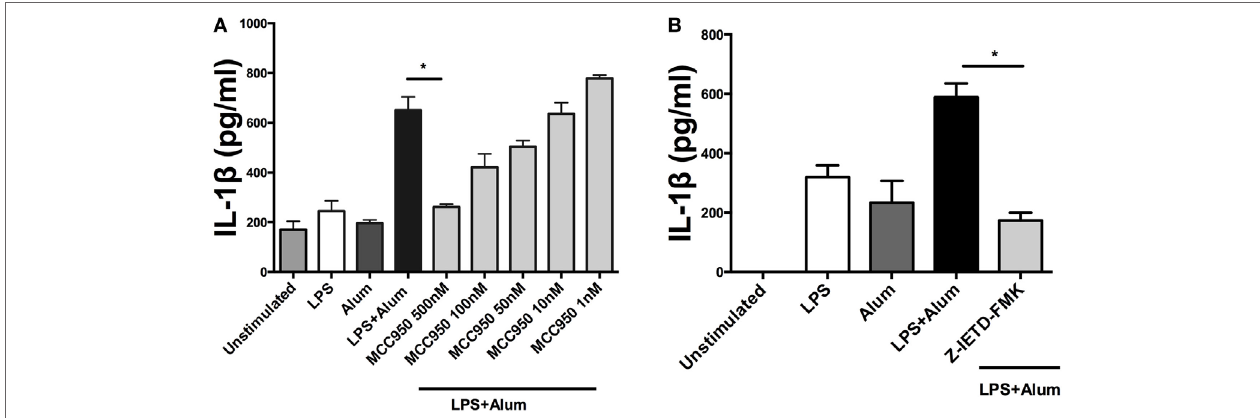
FigUre 5 | Alum-induced IL-1 β secretion is NLRP3 and caspase-8 dependent. LPS (100 pg/ml)-primed cells from three animals were incubated with MCC950 (500, 100, 50, 10, and 1 nM) (a) and Z-IETD-FMK (10 µm) (B) . After 40 min, the cells were stimulated with alum (50 µg/ml) for 24 h and supernatants were then harvested and analyzed by ELISA for IL-1 β . For ELISA analysis, results are mean cytokine concentrations ( + SEM) in supernatants that were tested individually in triplicate. * p < 0.05, ** p < 0.01, *** p < 0.001 were calculated using